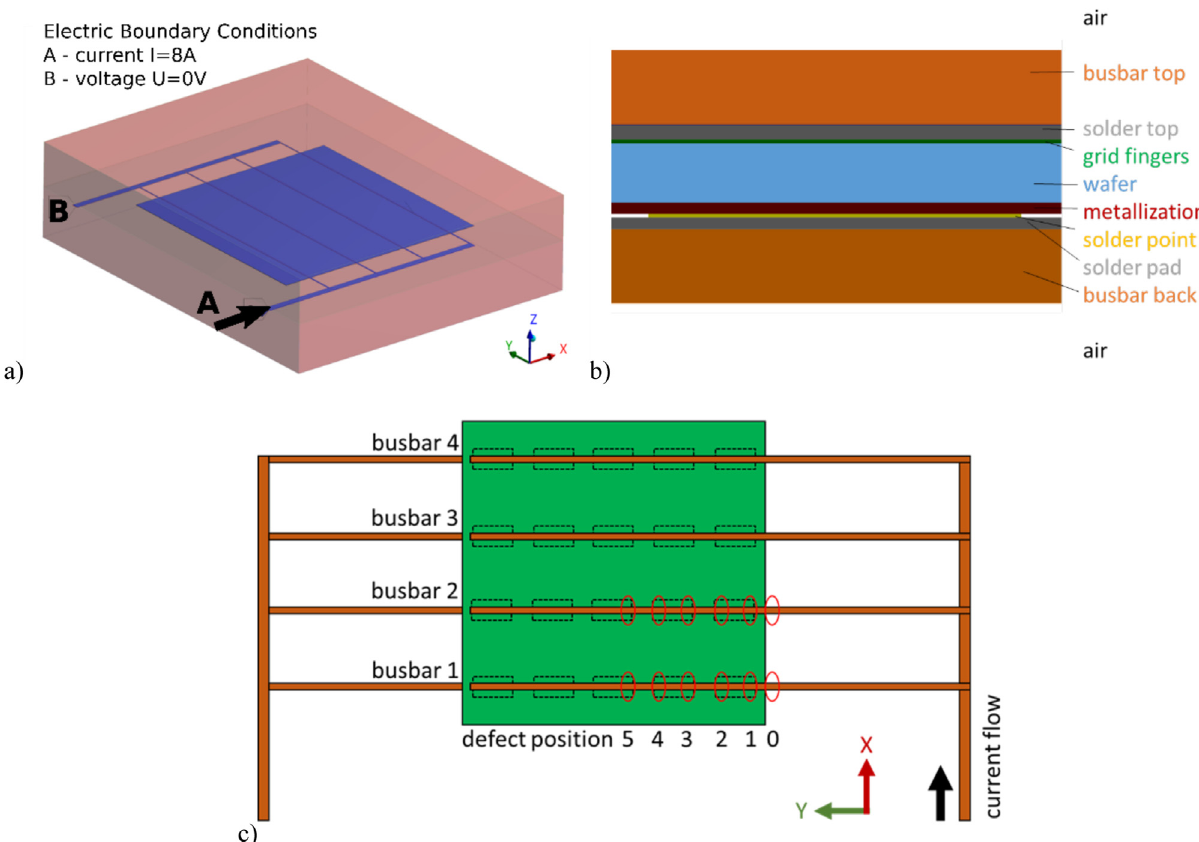
Fig. 2. FE-model of a four-busbar solar cell showing the electric boundary conditions (a) a cross section of the layer stack (b) as well as an overview of the numbering of busbars and defect positions